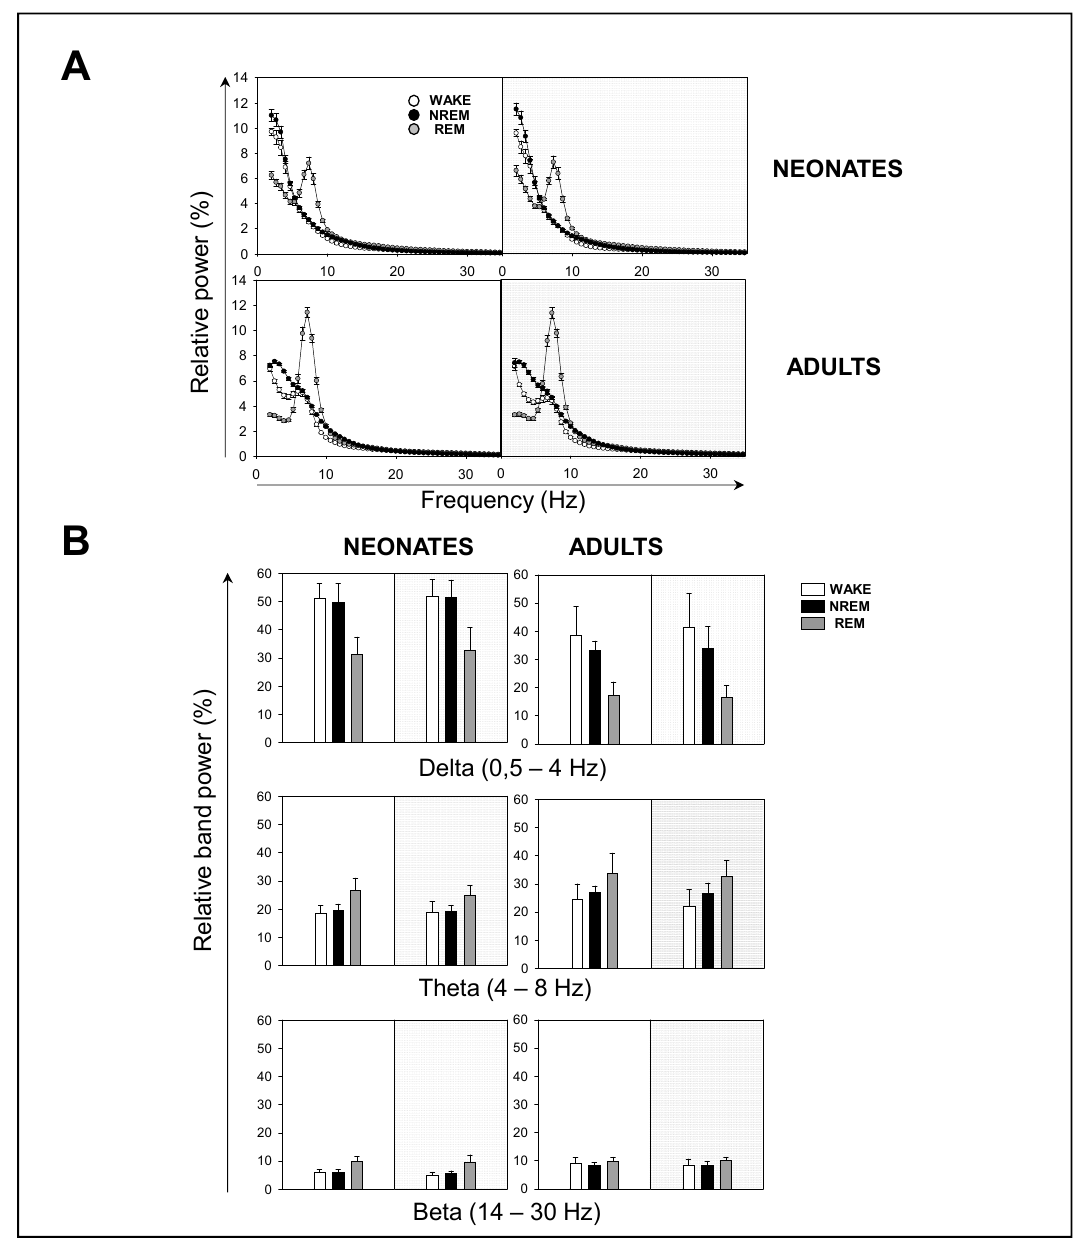
Figure 4. Sleep–wake EEG spectra during behavioral states in neonatal and adult mice. ( A ) Influence of light/dark cycle in the relative power of EEG during behavioral states in neonatal (top panels) and adult (bottom panels) mice. ( B ) Relative band power of EEG in delta ( δ ), theta ( θ ), and beta ( β ) during behavioral states. Data shown as mean ± SEM of either 18 or 27 recordings retrieved from 6 neonatal or 11 adult mice,